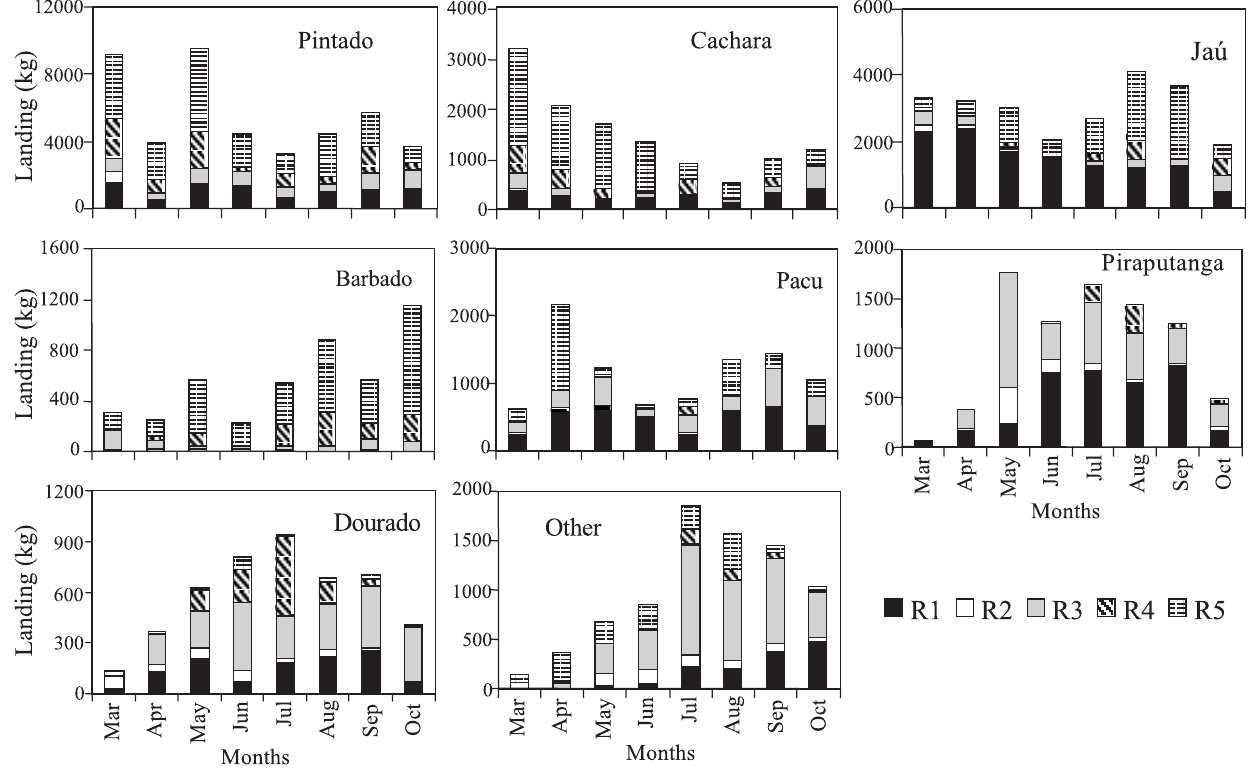
Fig. 6. Landing by species and region of the rio Cuiabá in